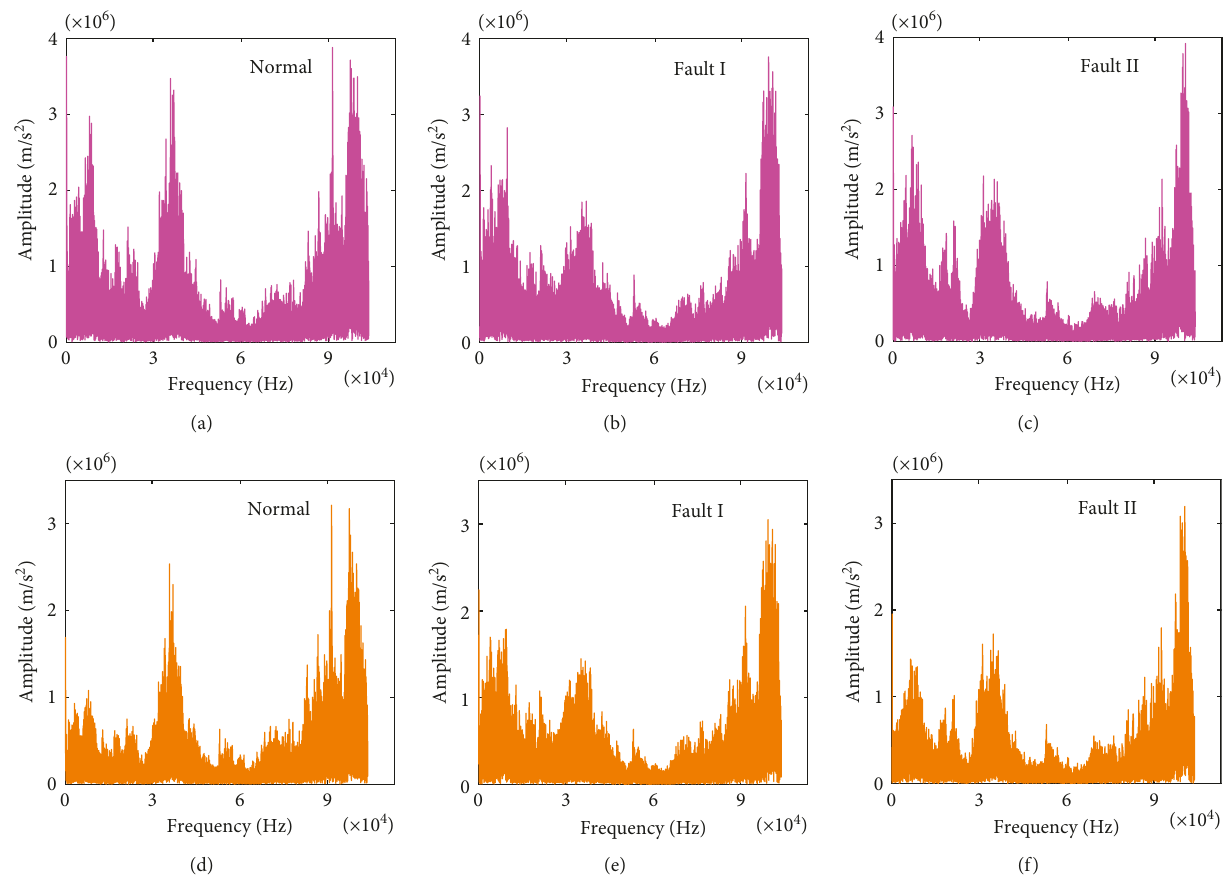
Figure 19: The original signals and the signals filtered by the YPT in the frequency